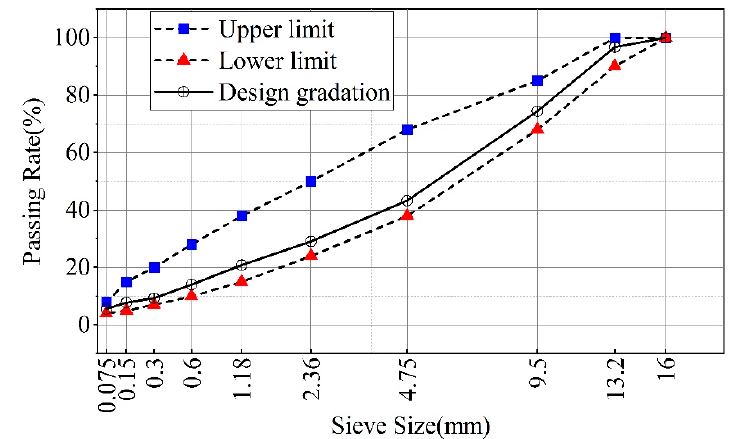
Figure 3. Design gradation of AC-13. Table 4. Volume parameters of AC-13.